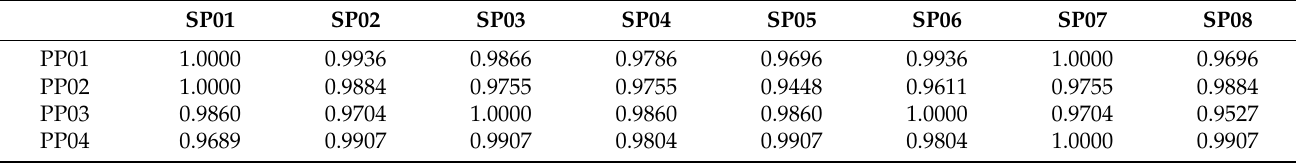
Table 5. Exponentially weighted